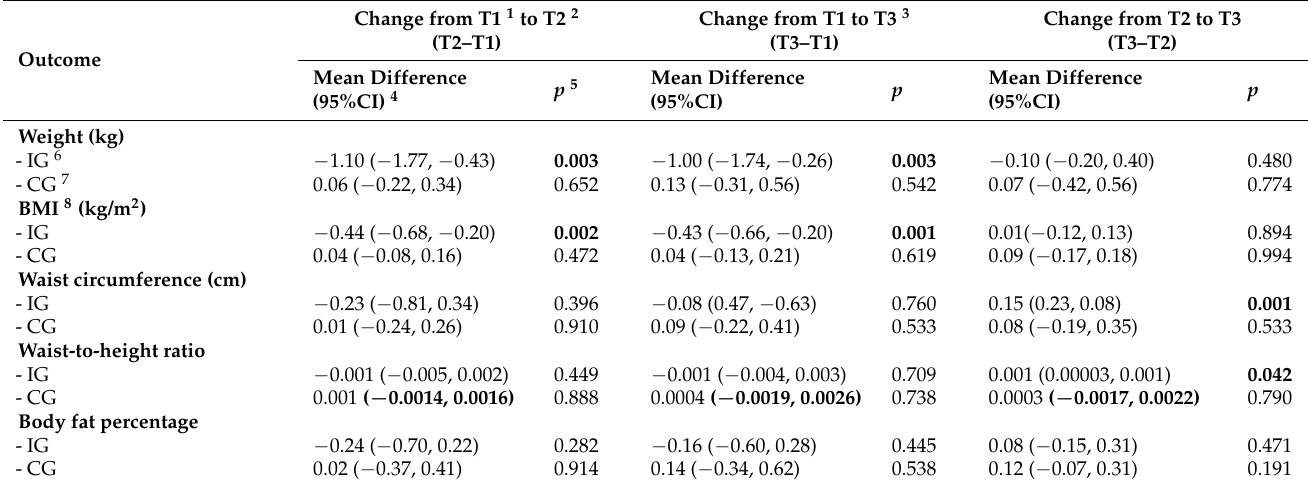
Table 3. Within-group differences in obesity-related outcomes.